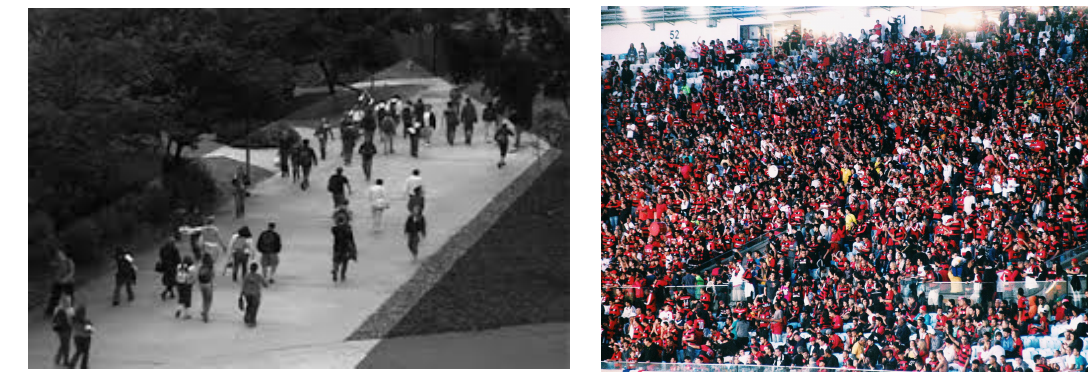
Figure 4. Two examples of crowd analysis